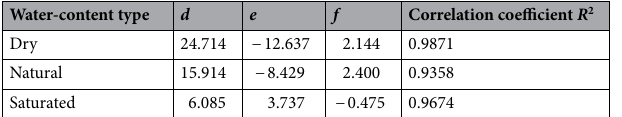
Table 3. Fitting coefficients of peak strain versus loading pressure